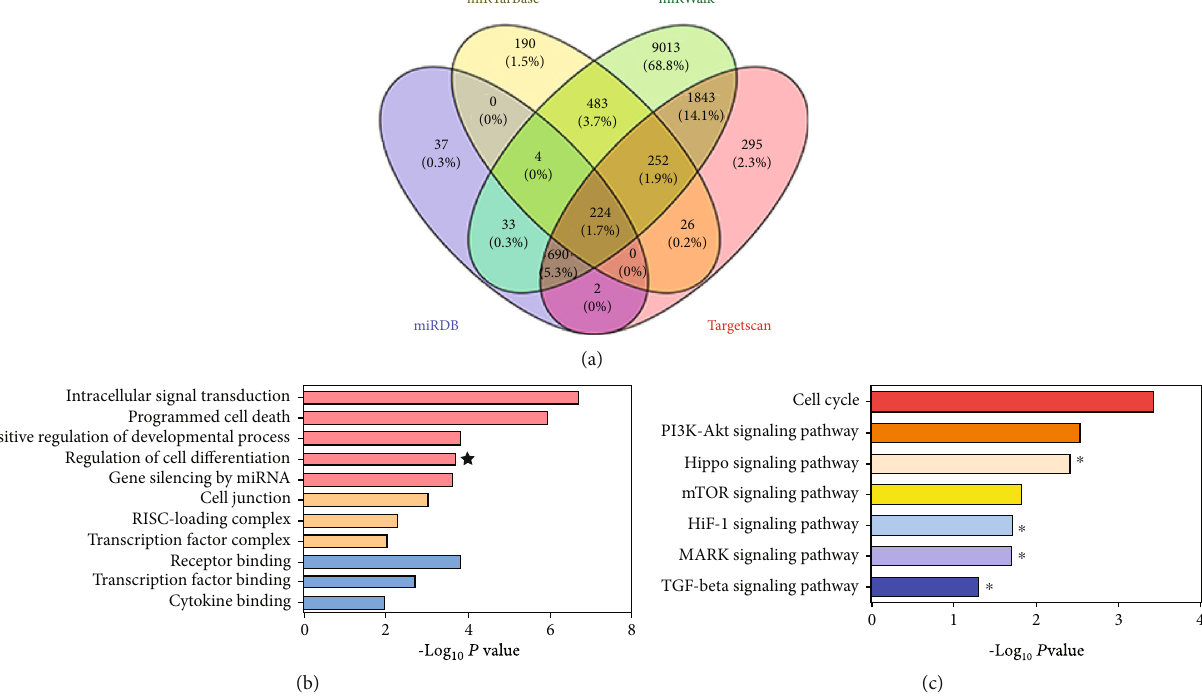
Figure 4: Bioinformatic analysis on the target gene of hsa-let-7b . (a) Venn diagram showed the number of hsa-let-7b target genes predicted by miRDB, miRTarBase, miRWalk, and TargetScan algorithms. (b) GO annotation suggested that these target genes are related to various biological processes. GO: domains directly related with reproduction. (c) KEGG pathway analysis indicated that these target genes are involved in kinds of cellular